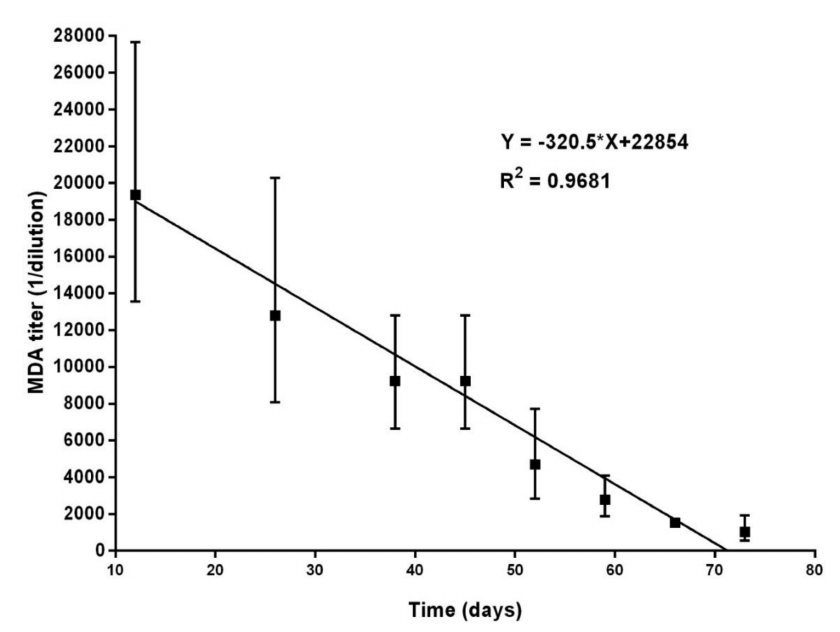
Figure 1. Serum NAb titers (MDA) in the offspring of one sow immunized with E2CD154. The sow received two injections of E2CD154 during the first trimester of pregnancy. Serum was collected on different days from six piglets and NAb titers were measured by NPLA. The GM and the confidence intervals of MDA titers are represented. The animals were kept in controlled conditions in an experimental station during the